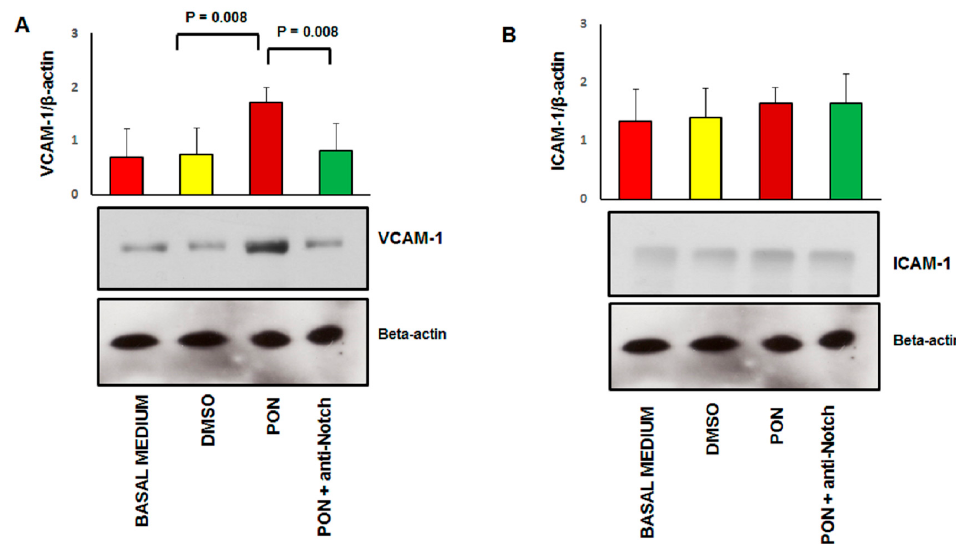
Figure 8. E ff ect of ponatinib and Notch-1 signaling inhibition on early endothalial activation markers. Western analysis of vascular cell adhesion molecule (VCAM-1, Panel ( A )) and intercellular adhesion molecular (ICAM-1, Panel ( B )) expression in HUVECs treated with 1.7 nM of ponatinib or DMSO, in the presence or absence of 1 µ g / mL of neutralizing factor anti-Notch-1 antibody, with β -actin serving as a loading control. The bar graph represents for each value the mean ± S.D. from 3 separate experiments. Abbreviations: Pon, ponatinib; DMSO, dimethyl